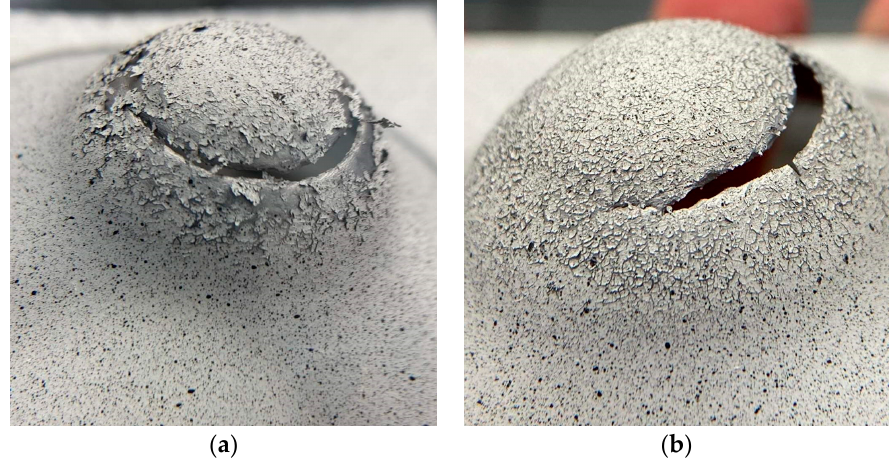
Figure 6. Separated paint after forming as shown for P9/SC4. ( a ) pick-up of the painting; ( b ) flaking of the painting. Table 13. Measurement results of usability tests (material: Al2, surface preparations: SC1, SC4, and SC9).